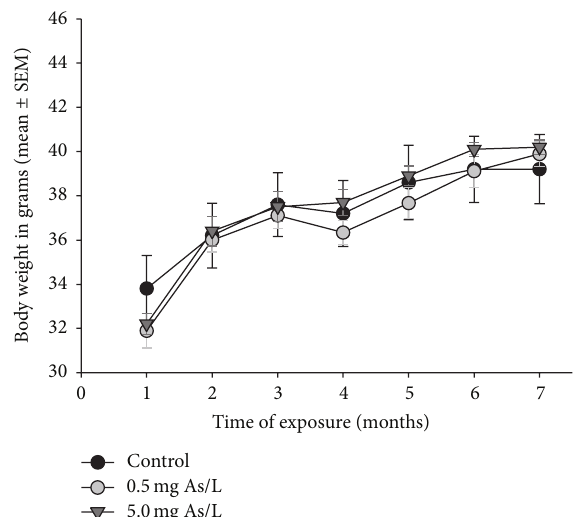
Figure 1: Growth rate of mice exposed to 0.5 or 5.0 mg As/L of drinking water for six months.